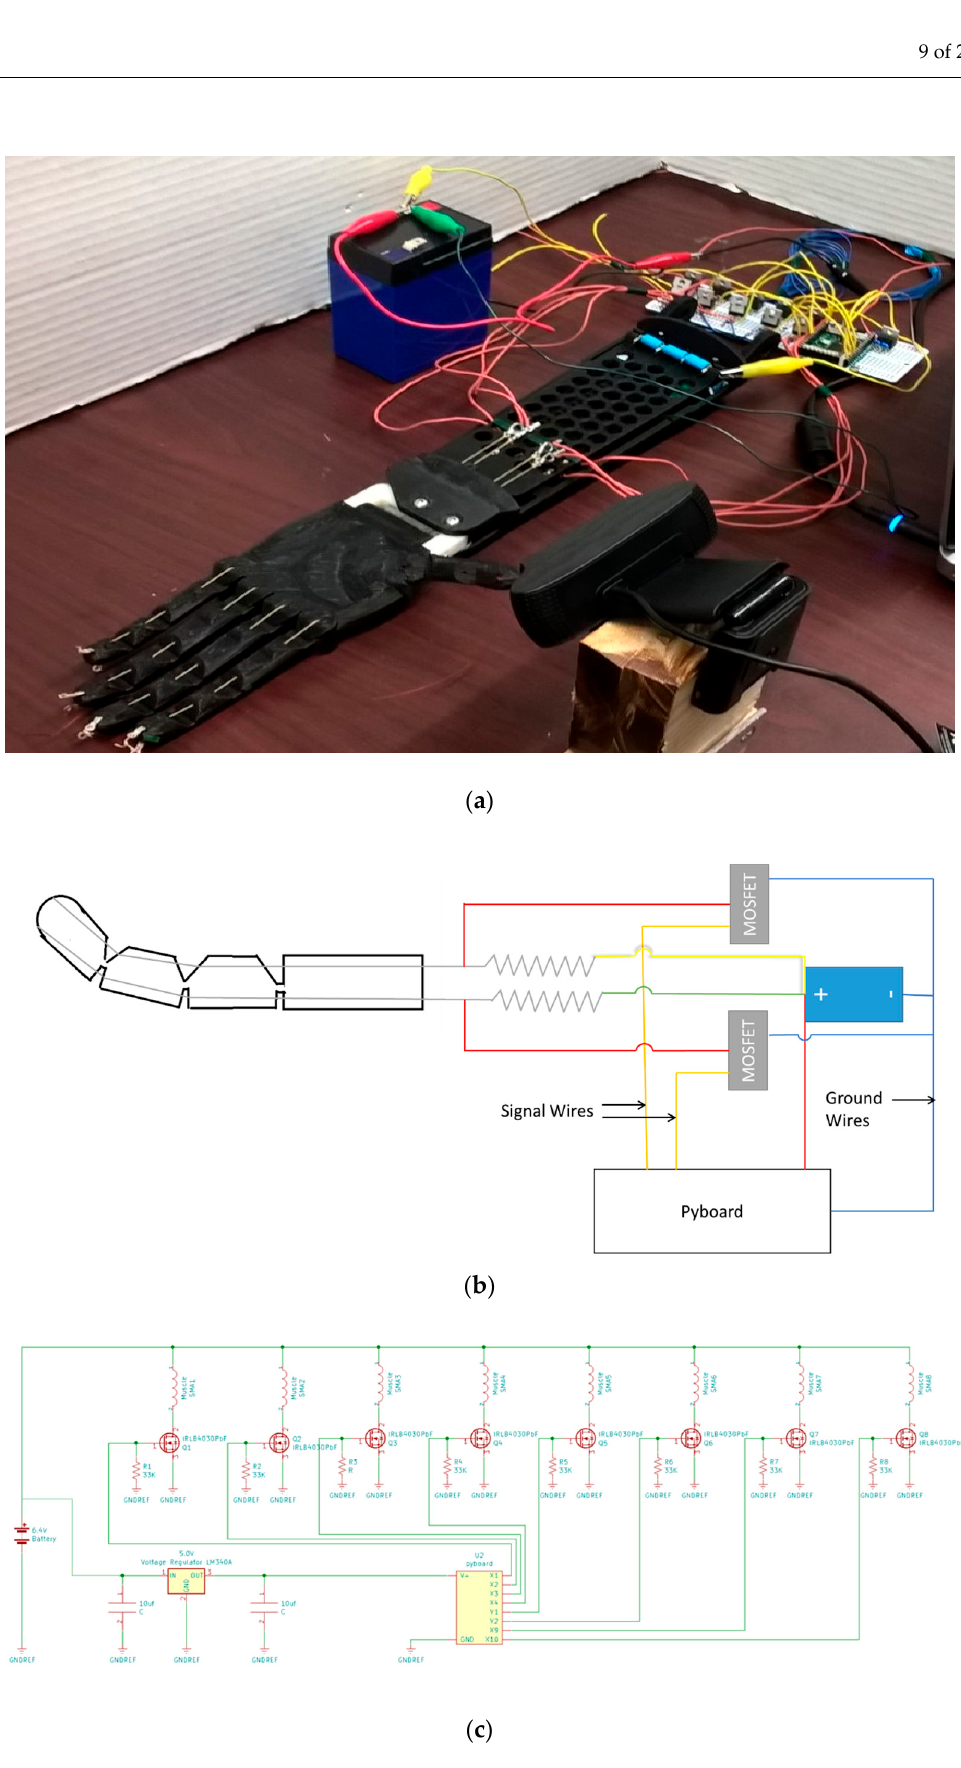
Figure 5. ( a ) Image of hand and circuitry; ( b ) functional schematic of the wiring and ( c ) circuitry schematic.